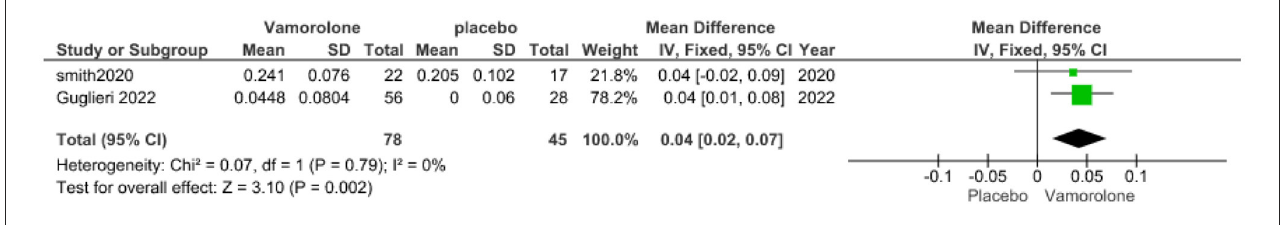
FIGURE2 TTSTAND outcome vamorolone vs. placebo.